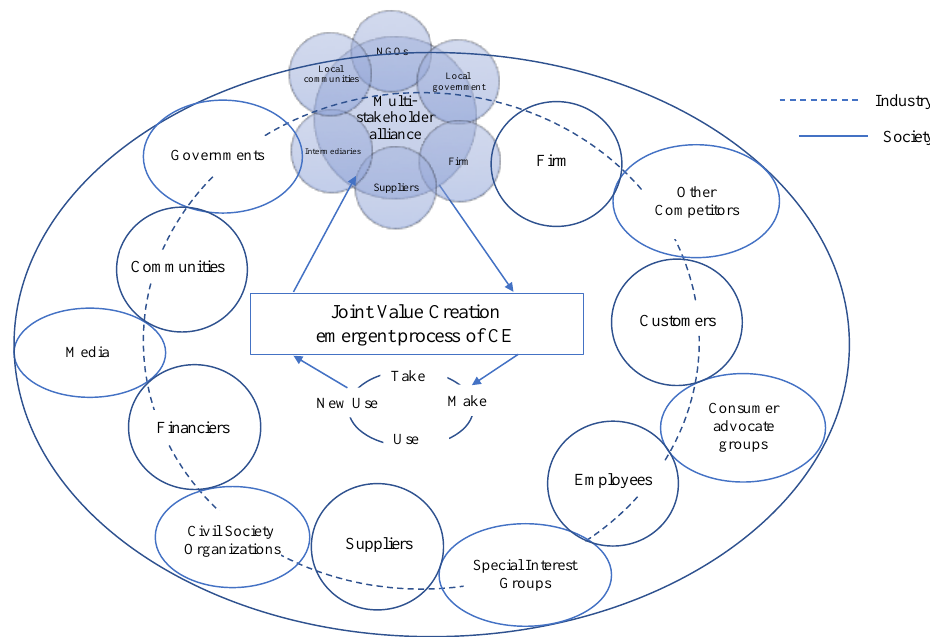
Figure 1: Relationship-Based Circular Thinking Map